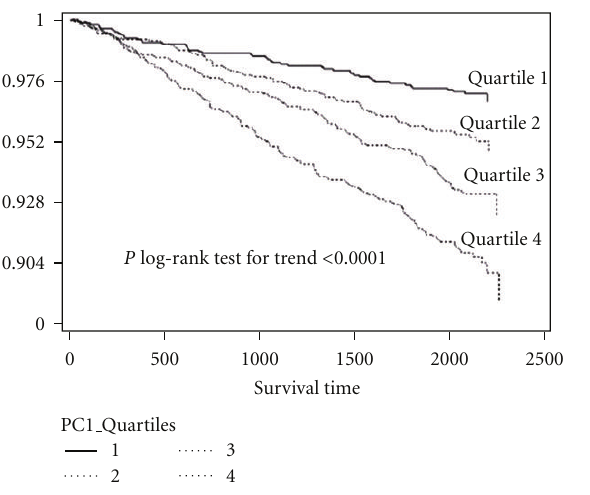
Figure 1: Kaplan-Meier survival curves for CVD events across quartiles of MetS-PC in MESA cohort after 5.5 years of followup.